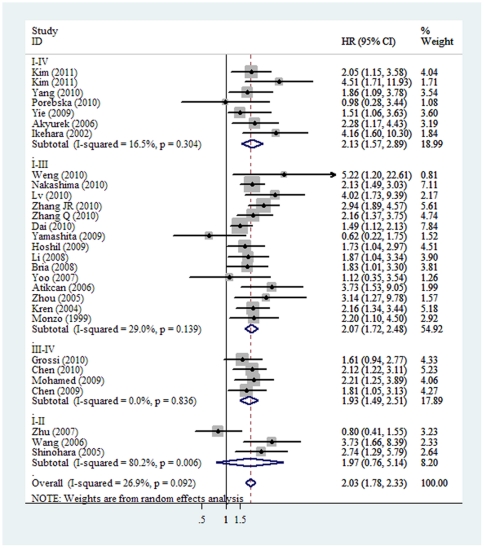
The association between survivin overexpression and overall survival of NSCLC stratified by HR estimation.The summary HR and 95% CIs were shown (according to the random effect estimations).